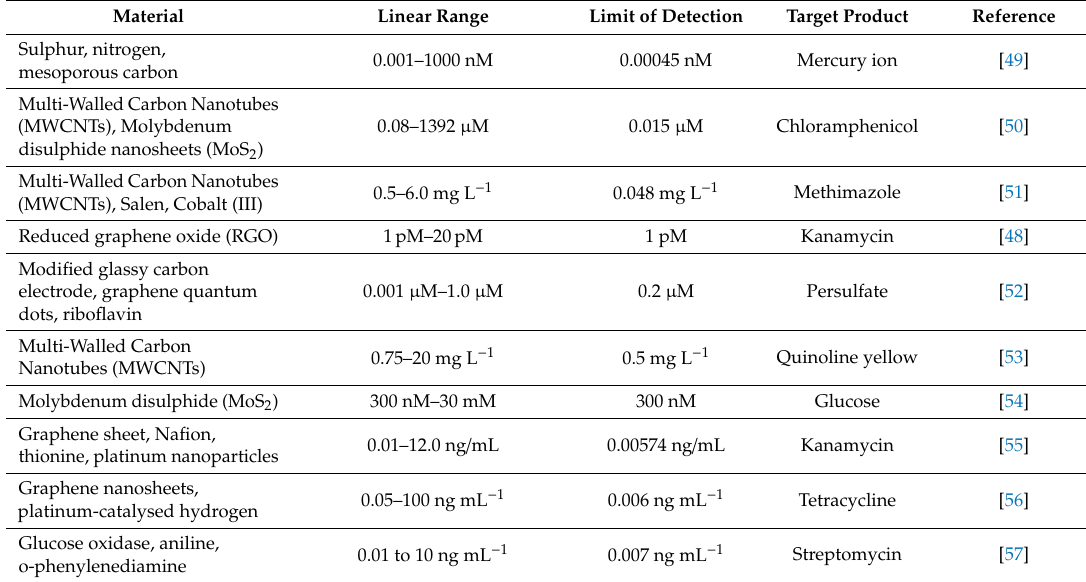
Table 2. Comparative study of selective research work done on the use of carbon-based materials for the fabrication and implementation of sensors for inspection of food